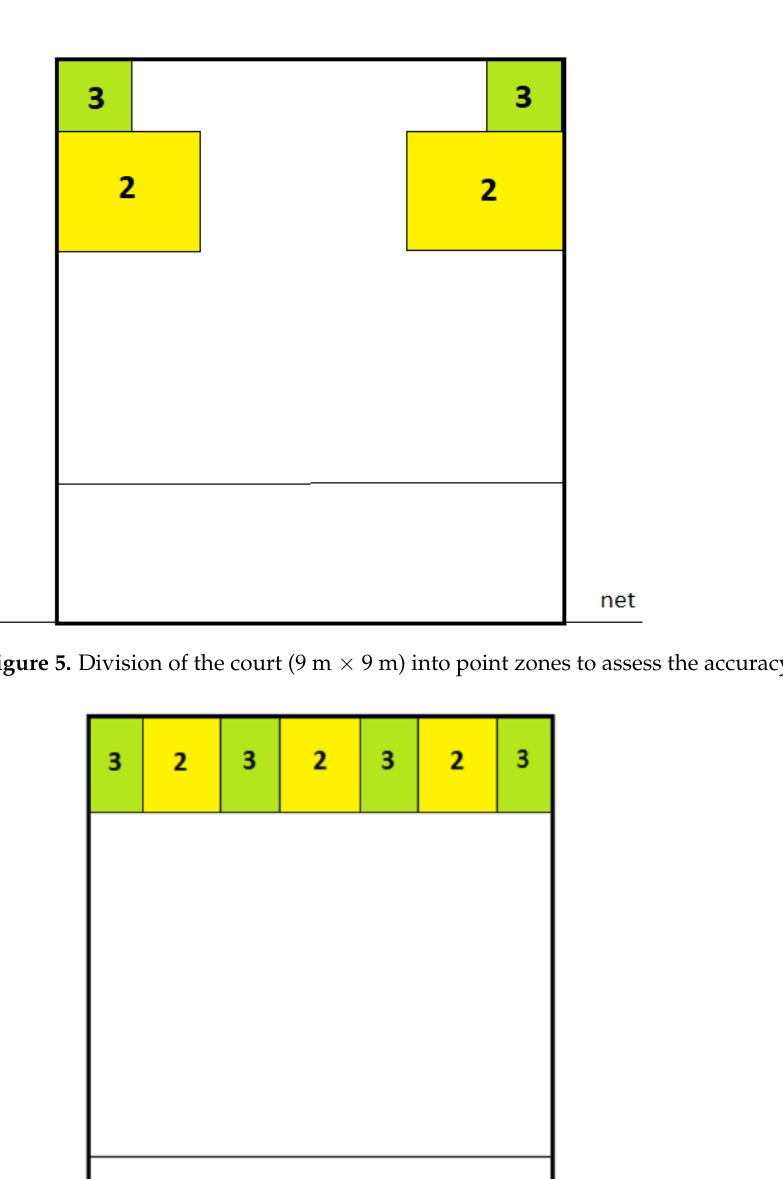
Figure 6. Division of the court (9 m × 9 m) into point zones to assess the accuracy of the volleyball service.